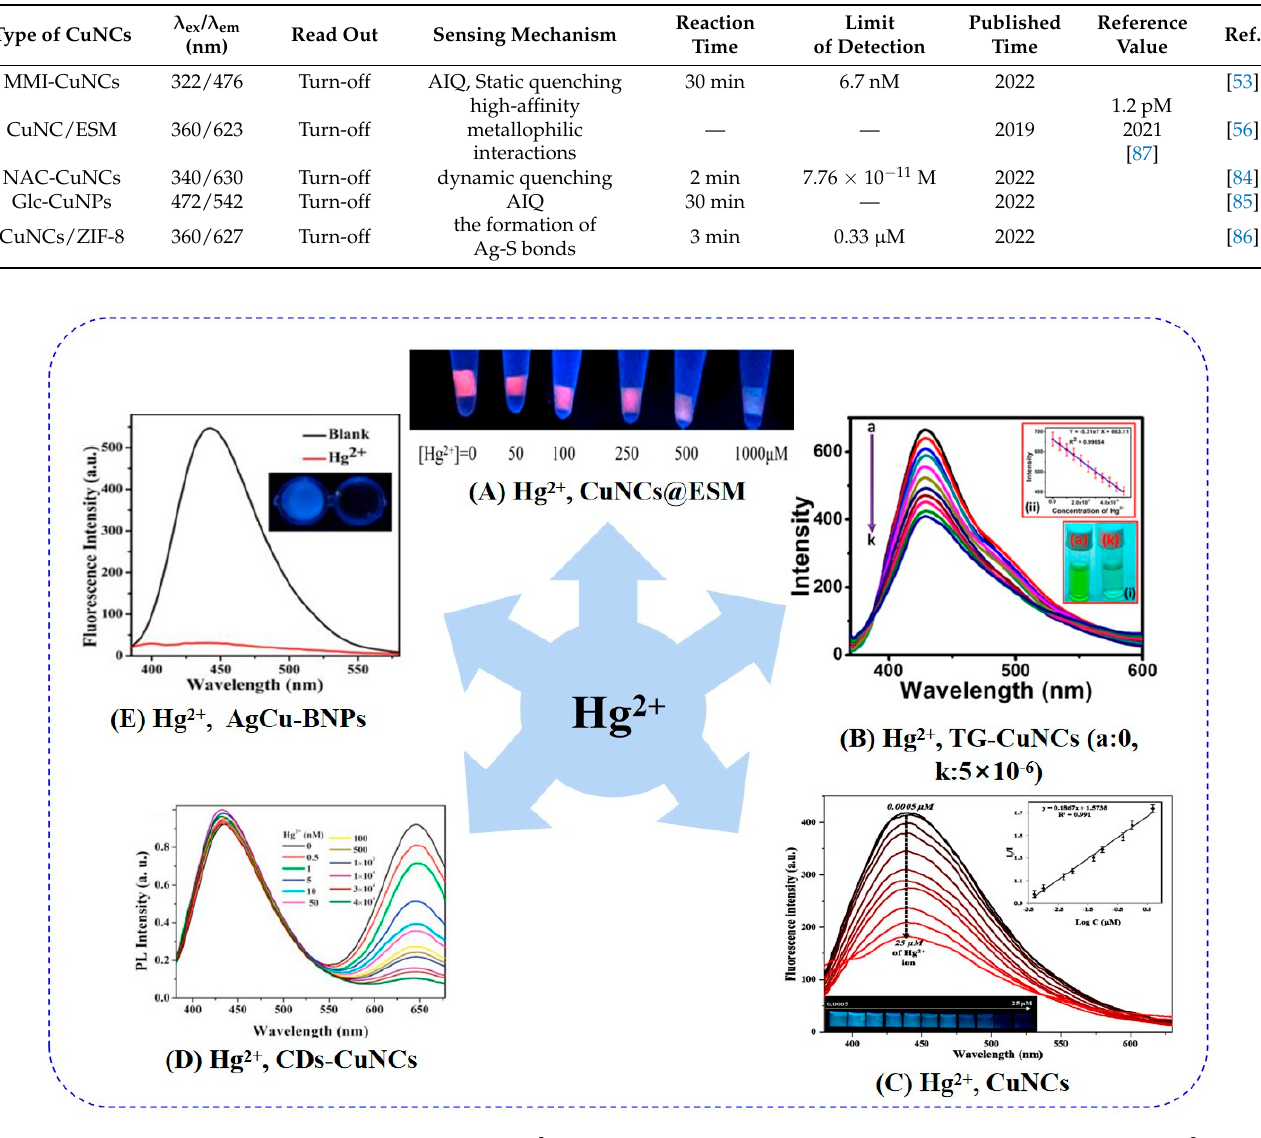
Table 1. Report on detection of Ag + by CuNCs.